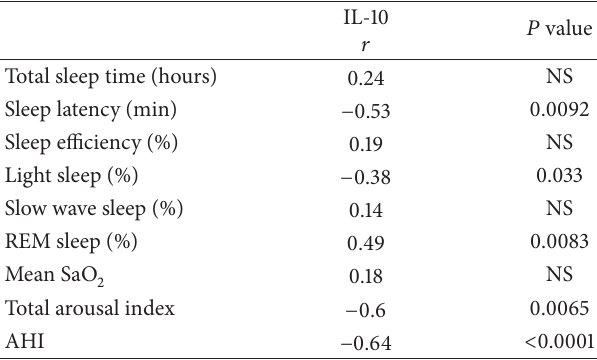
Table 3: Correlation between circulating levels of IL-10 and polysomnographic characteristics of the study